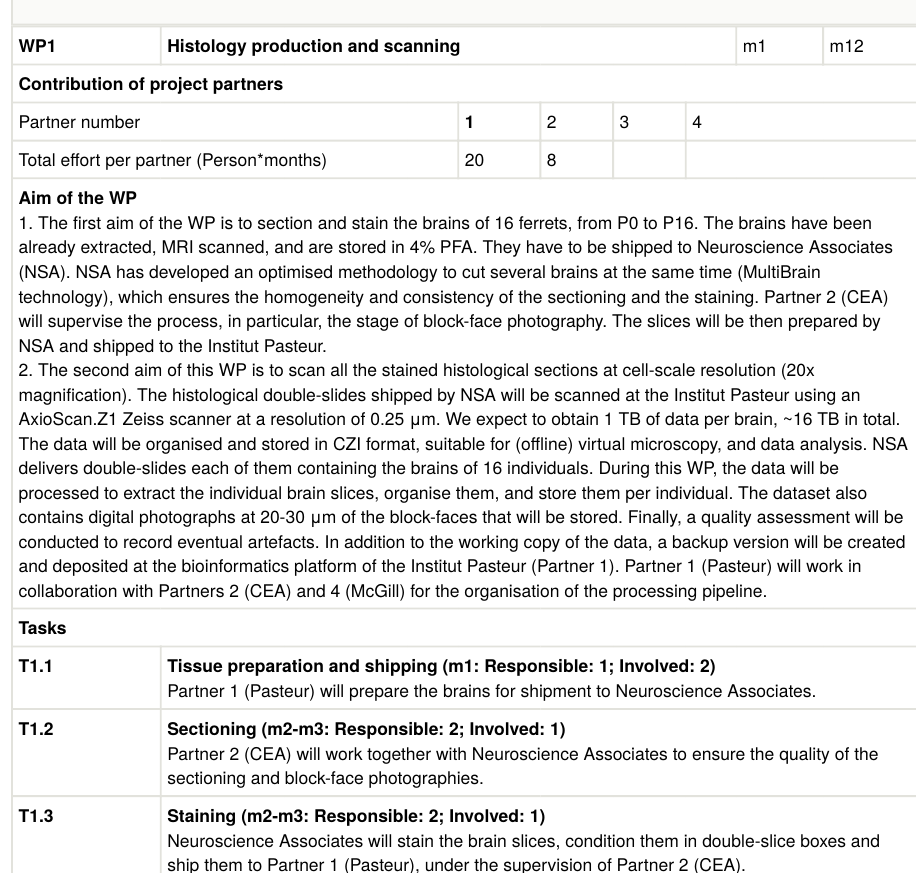
Work Package 1. Histology production and